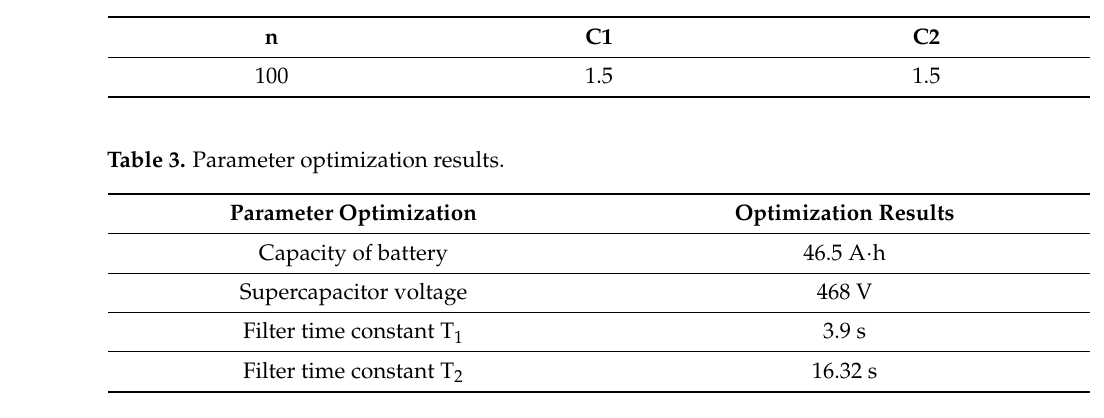
Table 2. Related parameters of the particle swarm optimization algorithm.